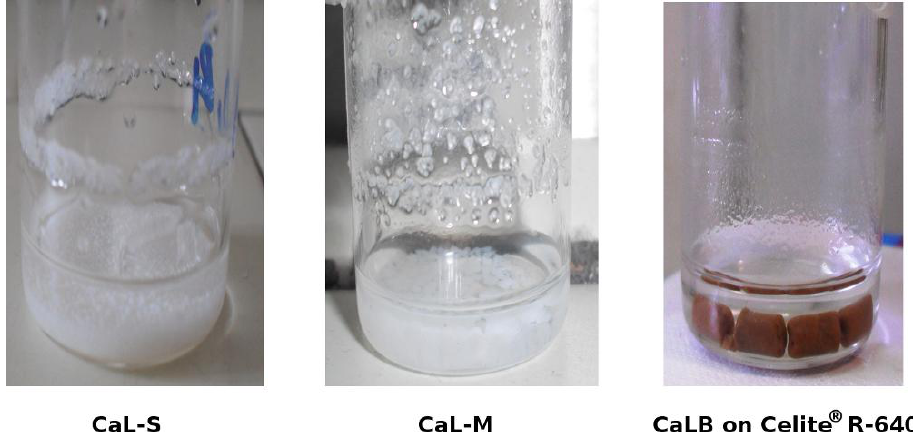
Figure 6. The appearance of the reaction system at the end of the methanolysis using the three preparations of CaLB considered in the